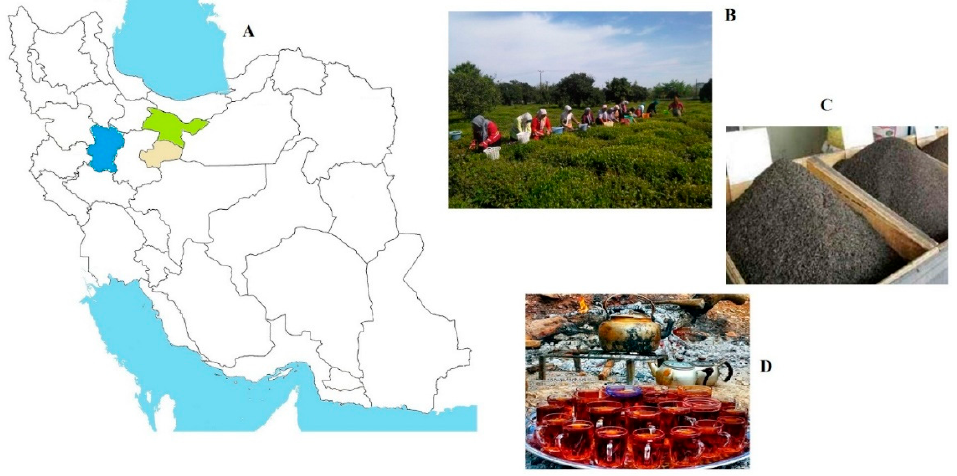
Figure1. LocationmapofperformedstudiesrelatedtofluorideinconsumedteainIran. ( A ):Distribution Figure 1. Location map of performed studies related to fluoride in consumed tea in Iran. ( A ): Distribution Studies, ( B ): Harvesting tea, ( C ): Dried and processed tea, ( D ): Tea made for drinking.